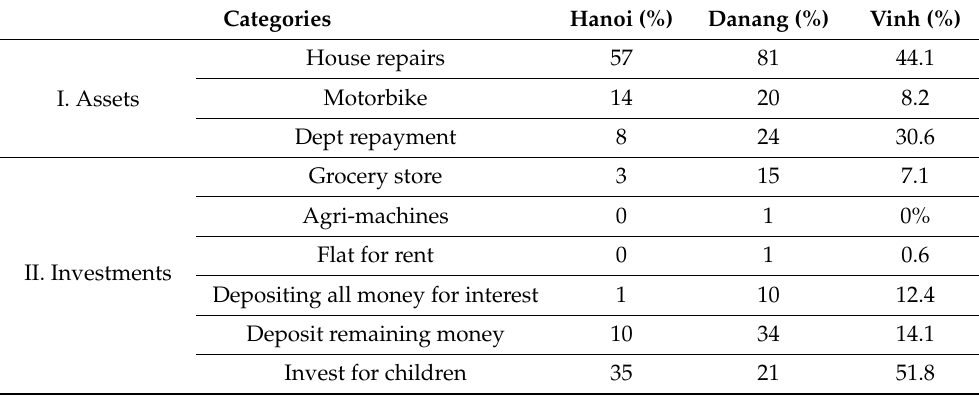
Table 5. The percentage of households who reported using land acquisition compensation money for the following spending and investment